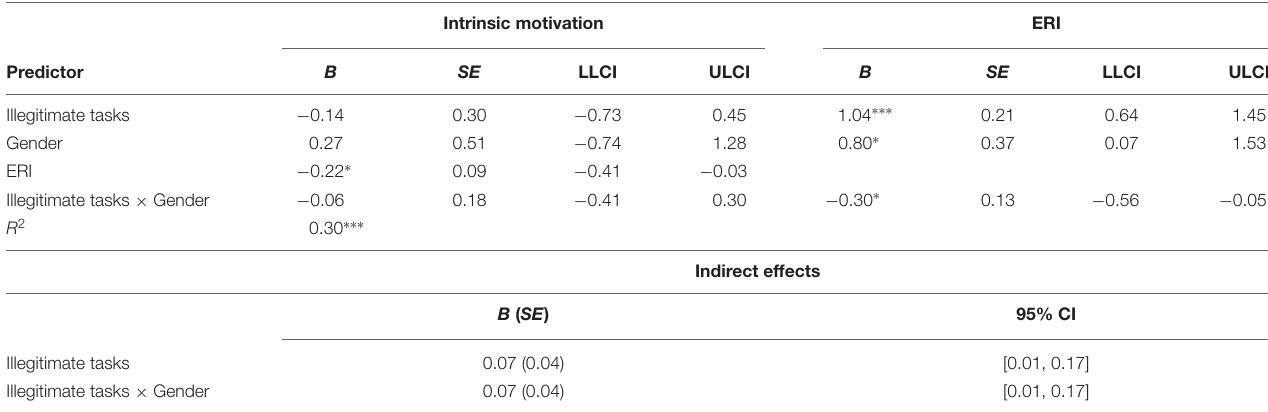
TABLE 3 | Results of test of moderated mediation with intrinsic motivation as